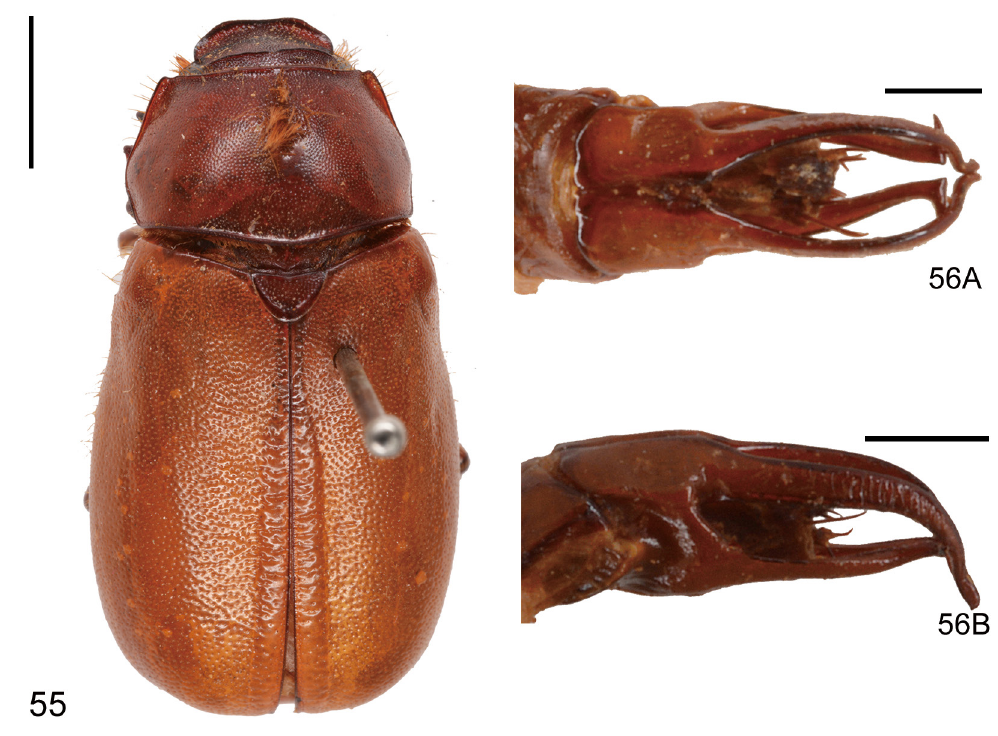
Figs 55–56. Hippotrichia hainana Arrow, 1948, lectotype ( BMNH). 55 . Habitus in dorsal view. 56 . Parameres in dorsal (A) and lateral (B) views. Scale bars: 55 = 5.0 mm; 56 = 1.0